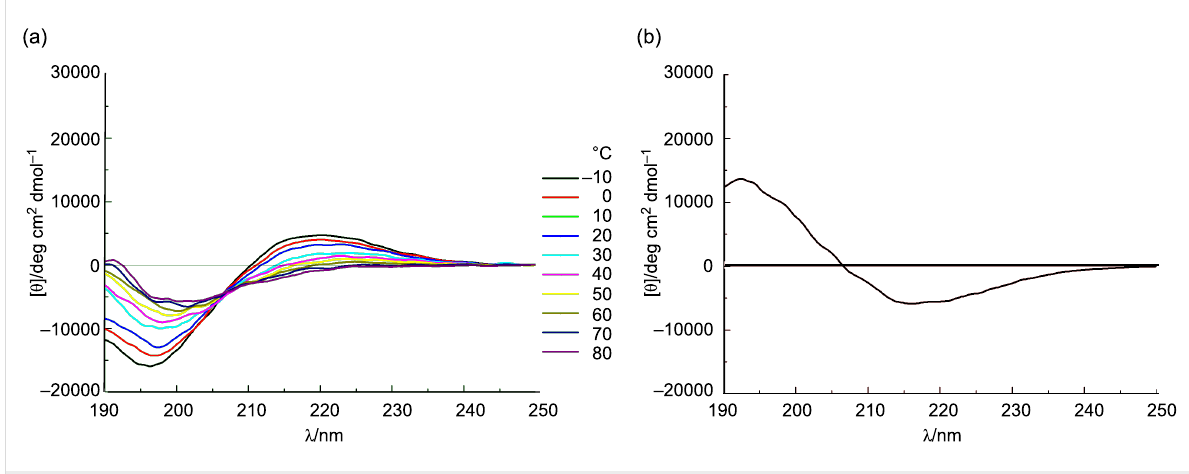
Figure 2: (a) Temperature dependent CD spectra of the glycosylated allo -L-Thr containing peptide 5 from − 10 to 80 °C in water, revealing an isodichroic point at 207 nm; and (b) the difference spectra between +80 and − 10 °C, indicating the contribution of a β -like structure.